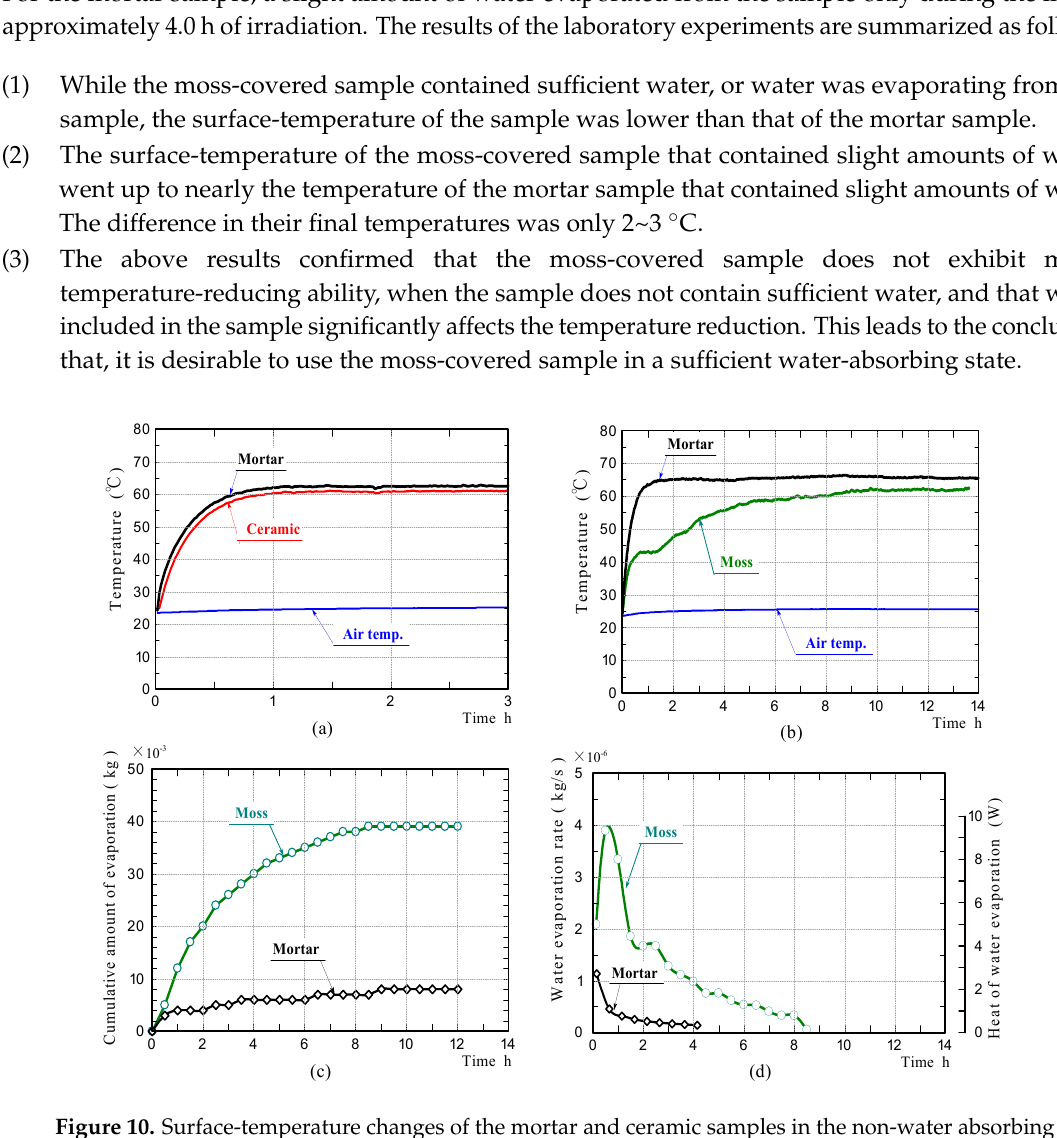
Figure 10. Surface-temperature changes of the mortar and ceramic samples in the non-water absorbing state ( a ), the mortar and moss-covered samples in the water absorbing state ( b ), amounts of water evaporated from the samples ( c ), and water evaporation rate ( d ) in laboratory experiments.